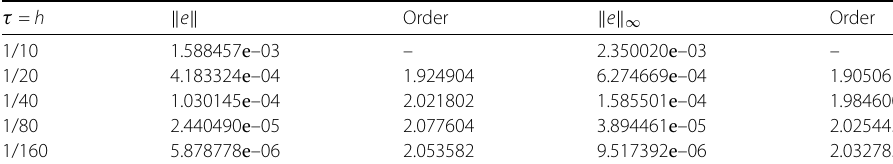
Table 3 Error and convergence order in time and space when (cid:4) = 0, α = β = γ = 1